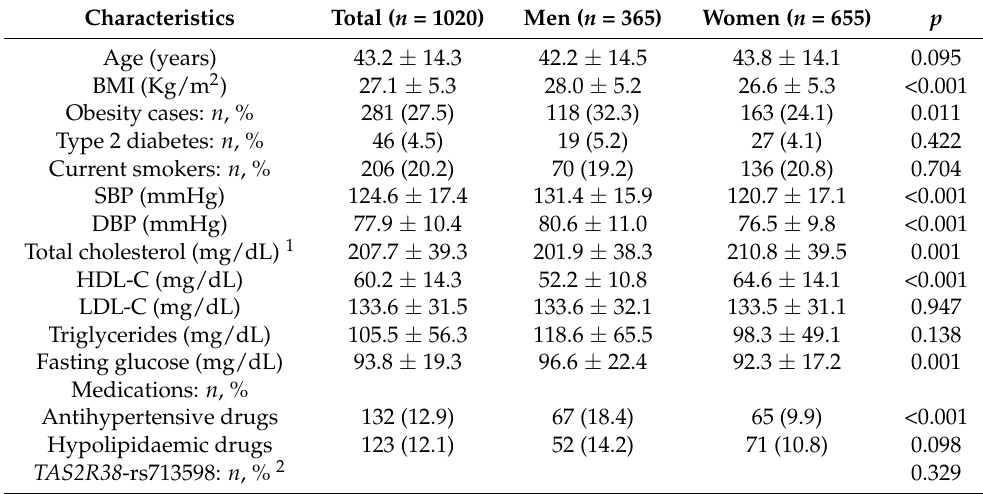
Table 1. Demographic, clinical and genetic characteristics of the study participants according to sex.